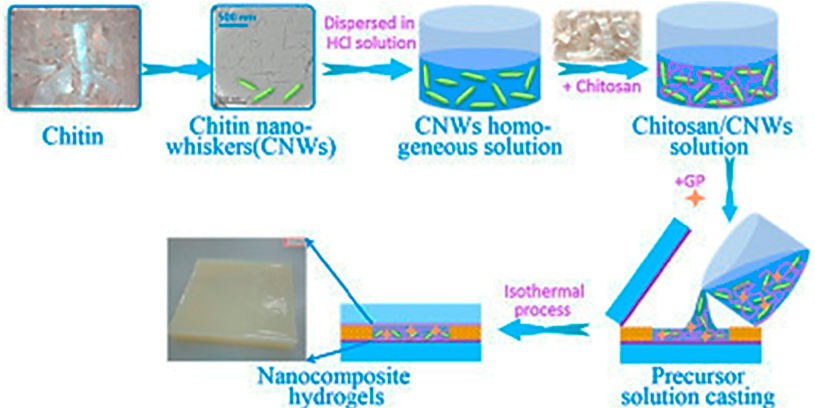
Figure 3. The graphic representation on the preparation of CNWs/CS nanocomposites, adopted from [32] with permission from Elsevier through copyright clearance center.